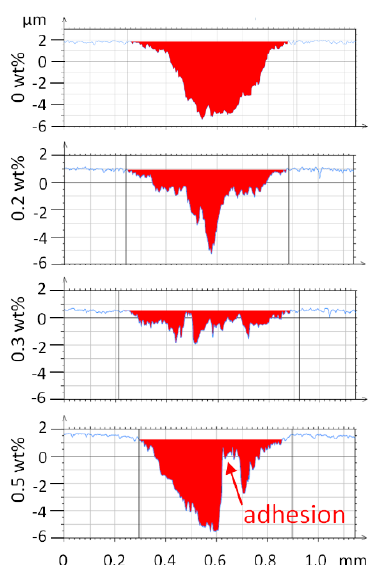
Figure 6. Cross-section analysis of the wear scars on the disc specimens under different nanoparticle concentrations